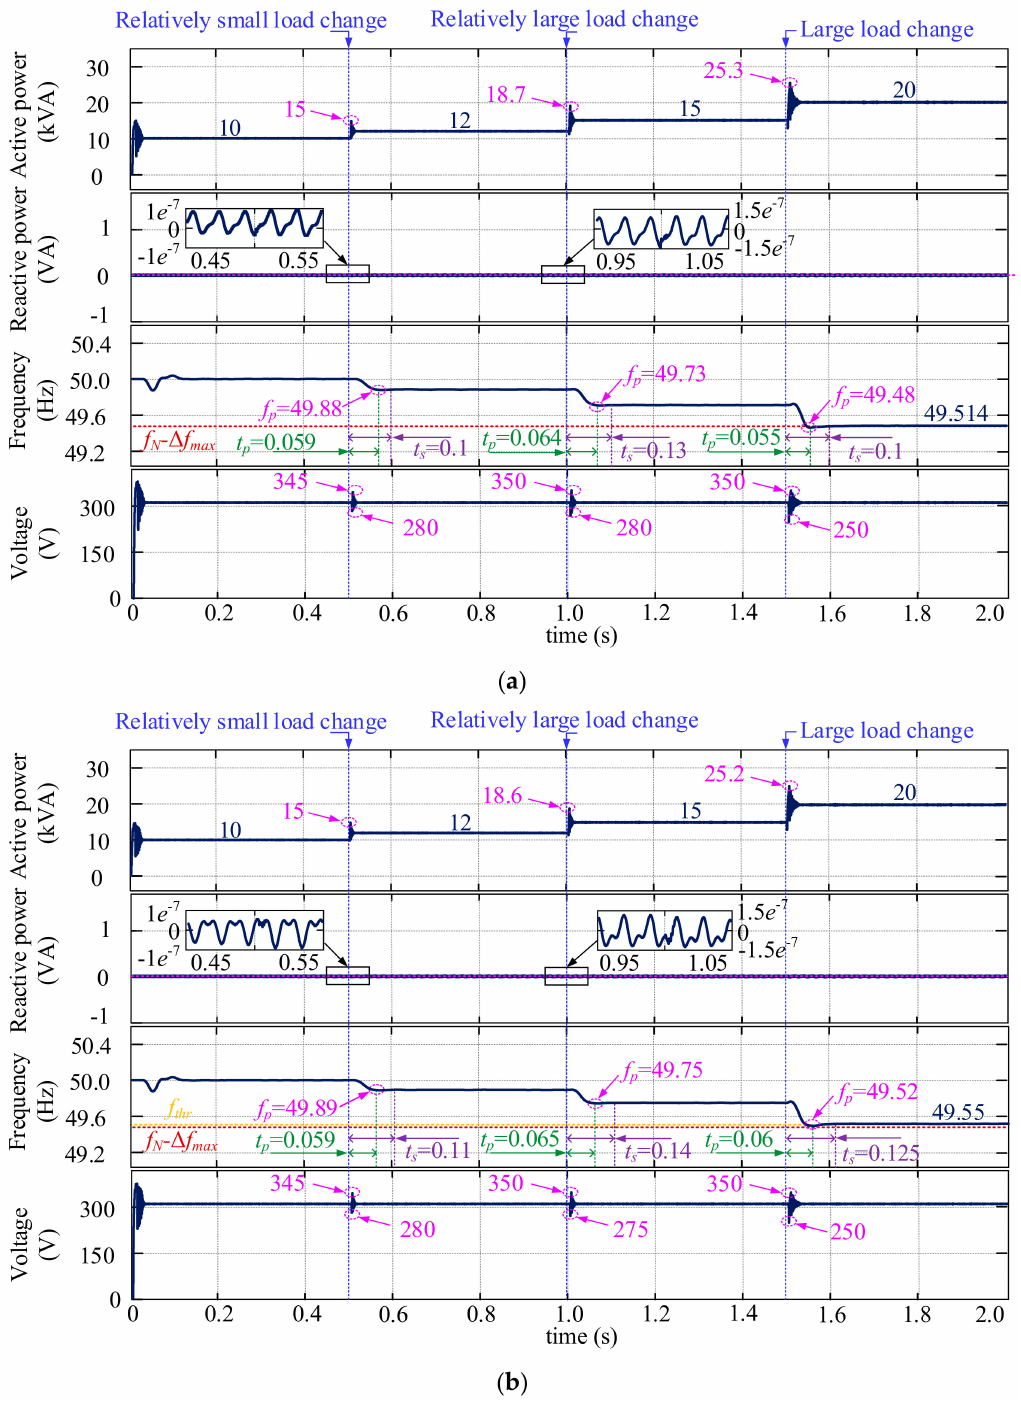
Figure 12. Simulation results of di ff erent VSG control strategies under di ff erent load disturbances. ( a ) Fixed-parameter based VSG; ( b ) Proposed fuzzy adaptive damping based